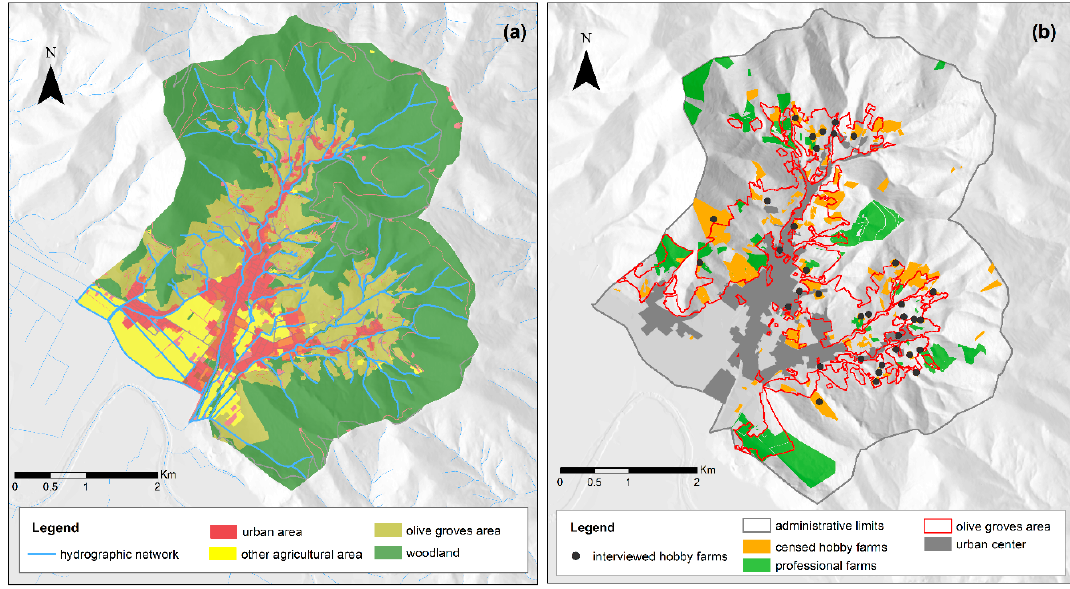
Figure 4. Land use ( a ) and censed olive grove managers ( b ) in the study area. Most parts of the light green olive grove surface are to be considered as property of or under management of hobby farmers.